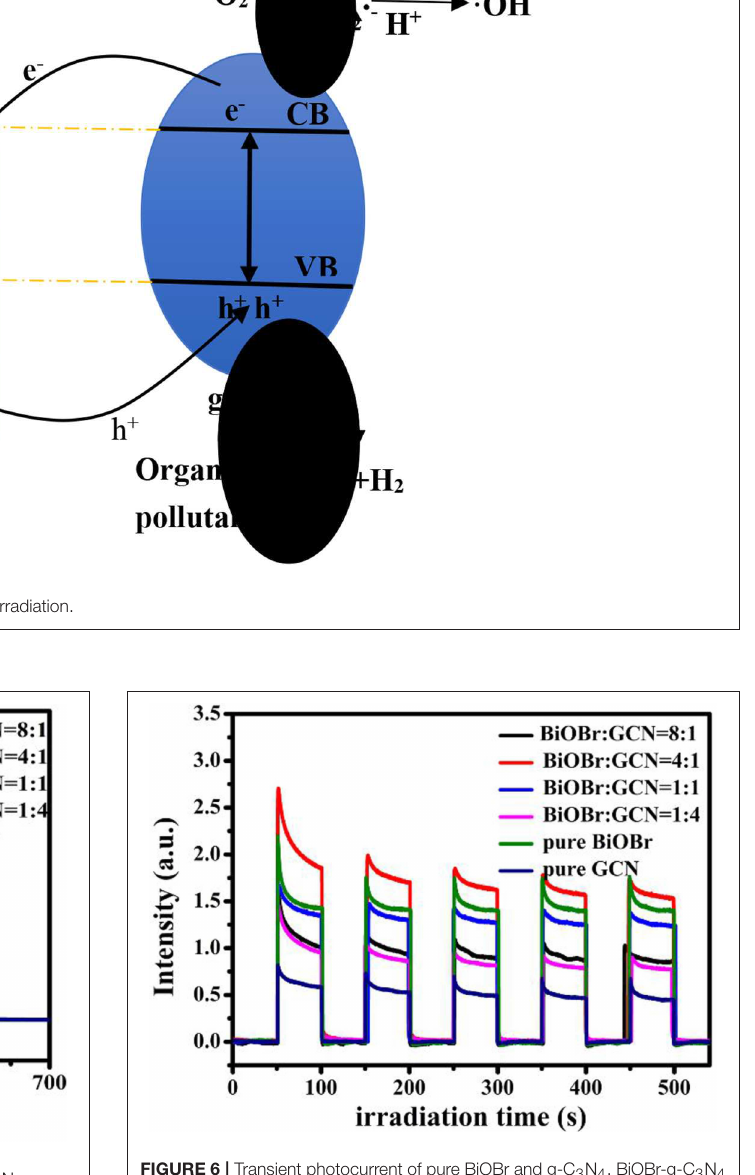
to the gravitational forces of between them, which is just like the force of gravity between man and earth. The PL emission peaks of BiOBr, g-C 3 N 4 , and composites were exhibited in Figure 5 . The g-C 3 N 4 exhibits a strongest emission peak at 466 nm. The blue shift occurred and the peak intensity decreased with the introduction of BiOBr to the heterojunction, and the BiOBr-g-C 3 N 4 -4:1 displayed the lowest emission peak intensity ( Figure 5 ). Considering the fact that BiOBr-g-C 3 N 4 -8:1 even had a higher PL intensity than that of the BiOBr-g-C 3 N 4 -4:1,